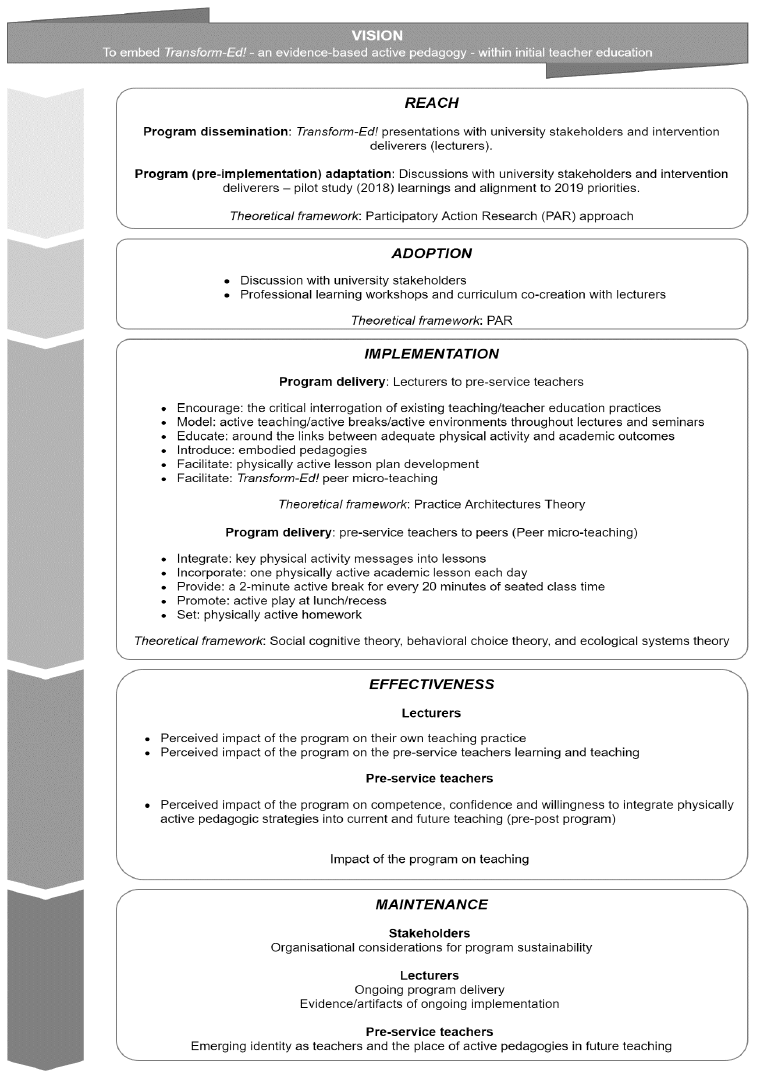
Figure 1. Conceptual overview of the trial implementation.